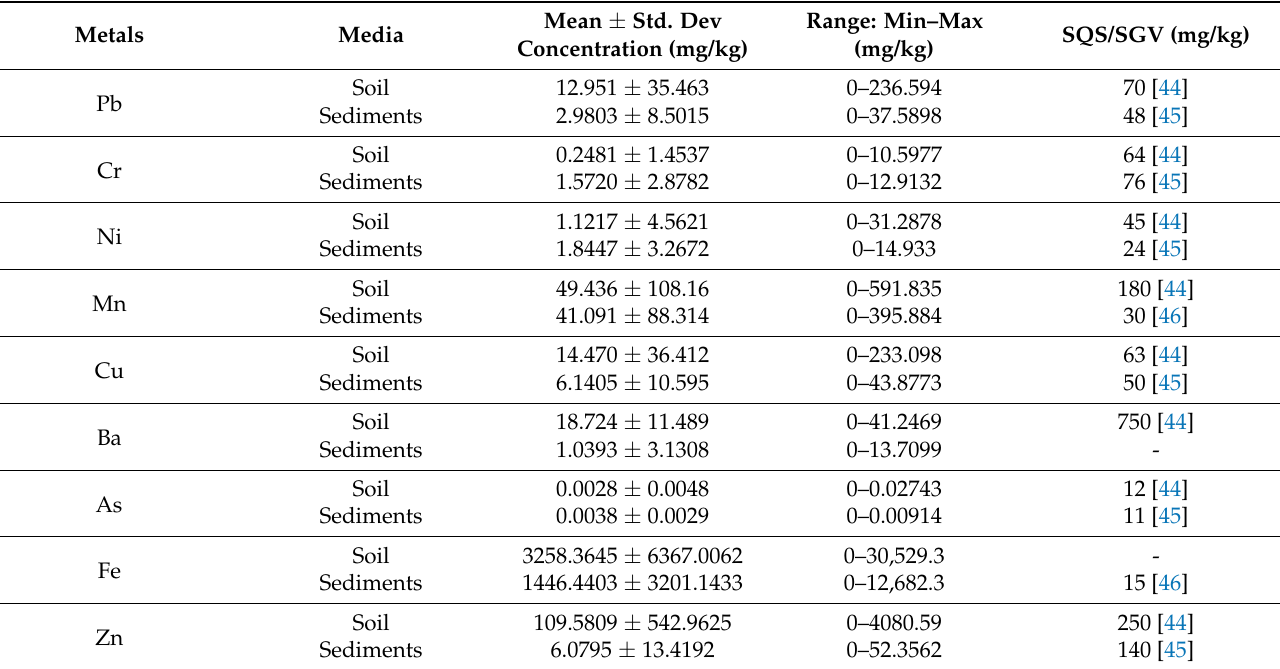
Table 2. Mean concentrations of MMs in soil (mg/kg) compared to soil quality standards (SQS) and sediment quality guidelines